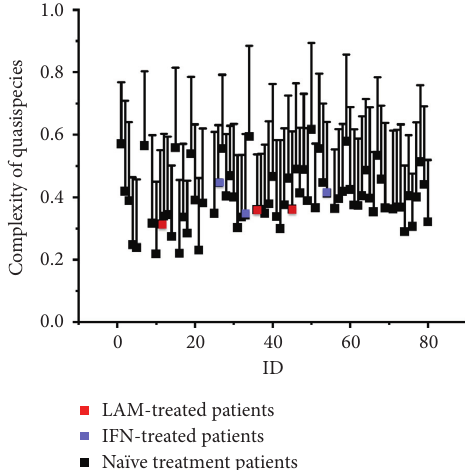
Figure 2: Scatter diagram of HBV quasispecies complexity. IFN: interferon; LAM: